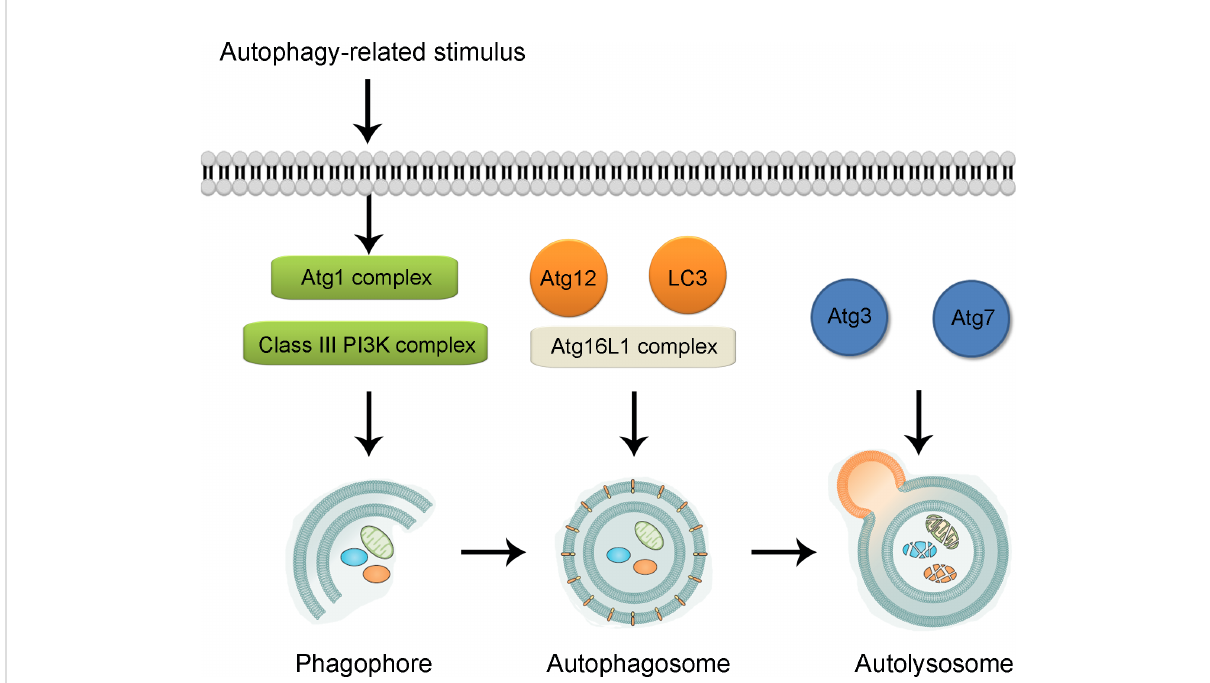
FIGURE 1 Illustration of biological process of autophagy. Under the challenge of autophagy-related stimulus, autophagy process is triggered through the formation of cup-shaped phagophore participated by Atg1 complex and Class III PI3K complex. With the formation of Atg16L1 complex and assistance of Atg12 and LC3, the bilayer membrane undergoes expansion, elongation and nucleation, which are sequestrated into double- membrane sphere-shaped autophagosomes. With the participation of Atg3 and Atg7, autophagosomes fuse with lysosomes to form the functional autolysosomes. Atg, autophagy-related gene. PI3K, phosphatidylinositol 3-kinase; LC3, light chain